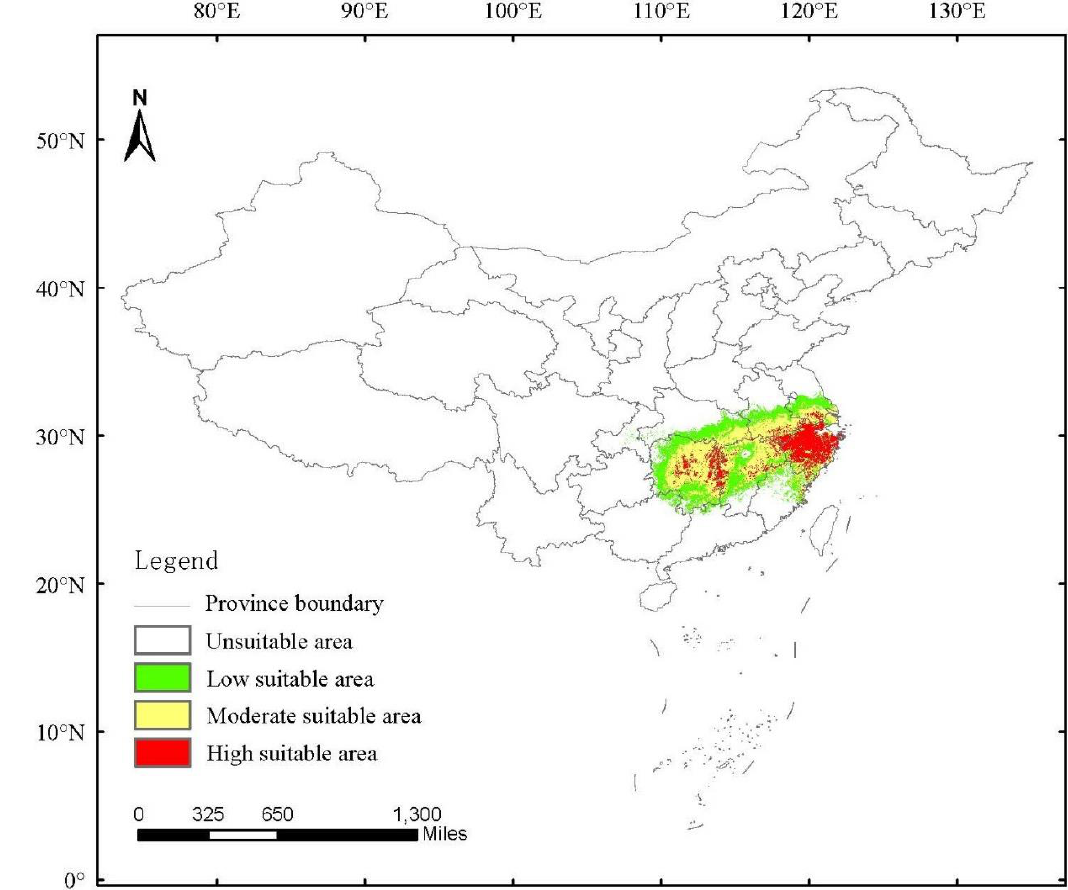
Figure 6. Present habitat distribution suitability of Hippotiscus dorsalis .